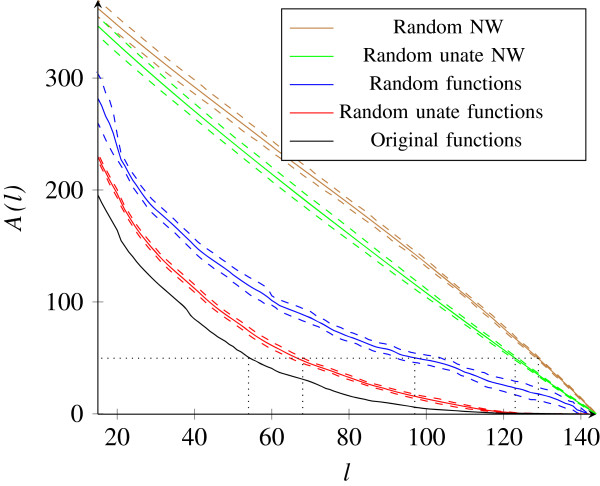
The upper bound A(l) on H(Y|Xτ(1),...,Xτ(l)) as a function ofl for theE. coli network and random networks.